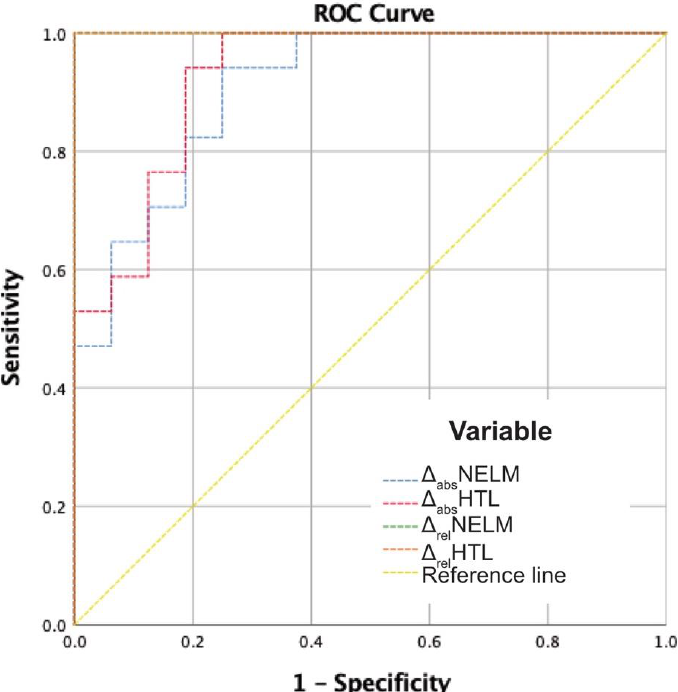
Figure 5. ROC analysis of the absolute and relative change variables in relation to the MCC deci-